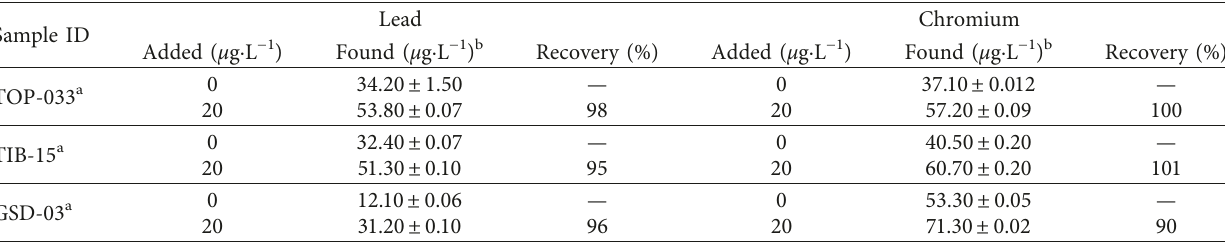
Figure 3: Calibration graph for Cr. Conditions: 0.005mol · L − 1 EDTA and 1mol · L − 1 HNO 3 . The error bars represent the standard deviation ( n � 3) for each point. Table 2: Simultaneous determination of Pb and Cr in marine